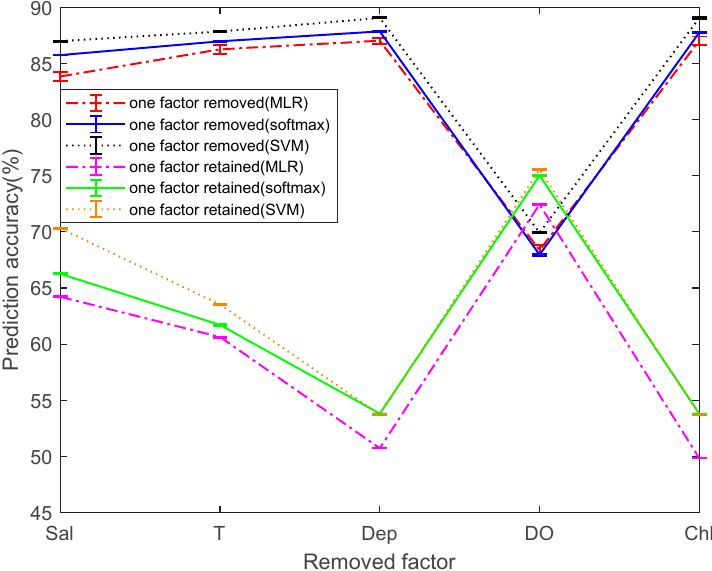
Figure 9. Prediction accuracy after one factor is removed or retained.